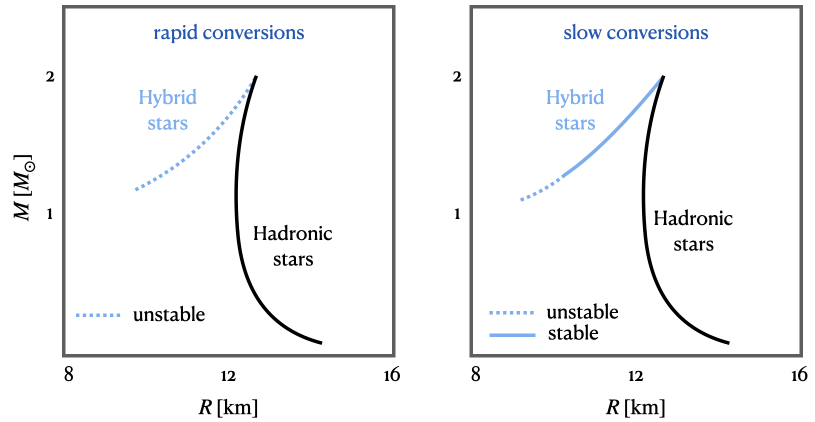
Figure 4. Mass–radius relationships for hybrid stars in the case of rapid and slow conversions. The curves represent qualitatively results that have been obtained with several combinations of realistic hadronic and quark equations of state [68–74,80]. In this figure, it is assumed that the hadron–quark interface occurs at high densities, thus, purely hadronic stars are possible up to ∼ 2 M (cid:12) . When rapid conversions are assumed (left panel), calculations show that the fundamental oscillation frequency of < 0, indicating that hybrid configurations (dashed lines) are dynamically hybrid stars verifies ω 2 0 unstable. Considering the same equations of state, but assuming that interface conversions are slow > 0 in spite of being in a branch with (right panel), it is found that many hybrid stars have ω 2 0